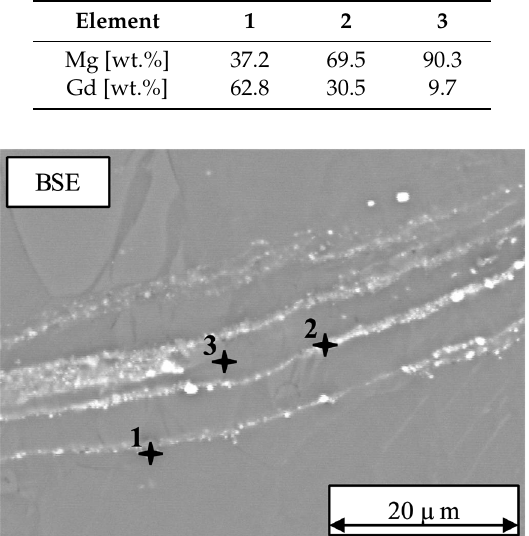
Figure 6. SEM micrograph obtained using the BSE mode of the as-received Mg-10Gd. Several lines of particles are curved inside the TZ and DZ of the Mg-10Gd material. EDS analysis was done at the three positions indicated to determine the Gd content. Table 2. EDS analysis from three spots shown in Figure 6.